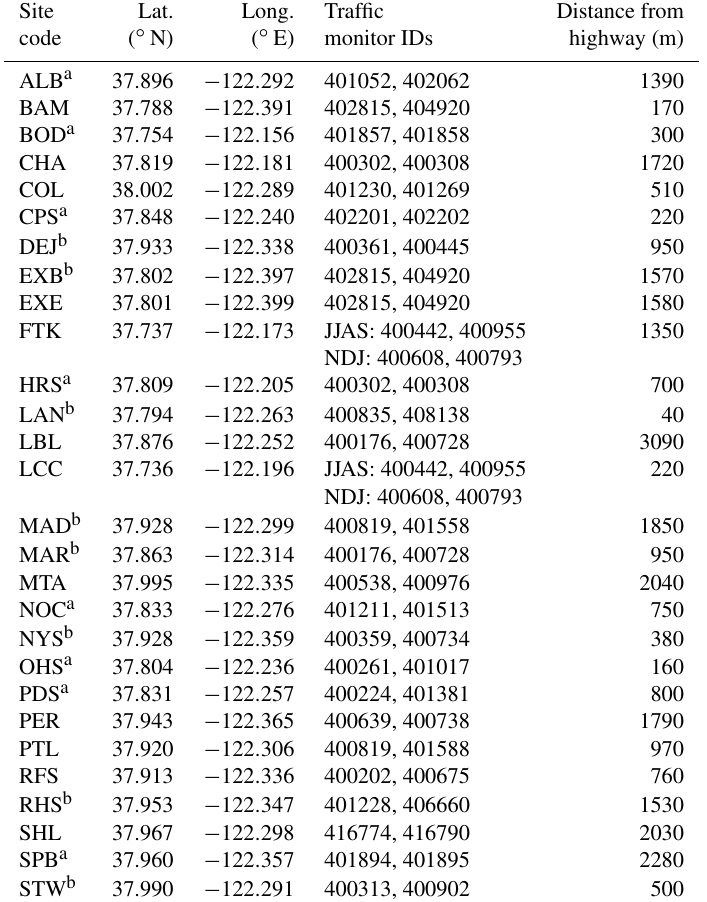
Table 1. List of site geo-coordinates, relevant traffic monitor IDs, and approximate distances from a highway. Site Lat. Long.